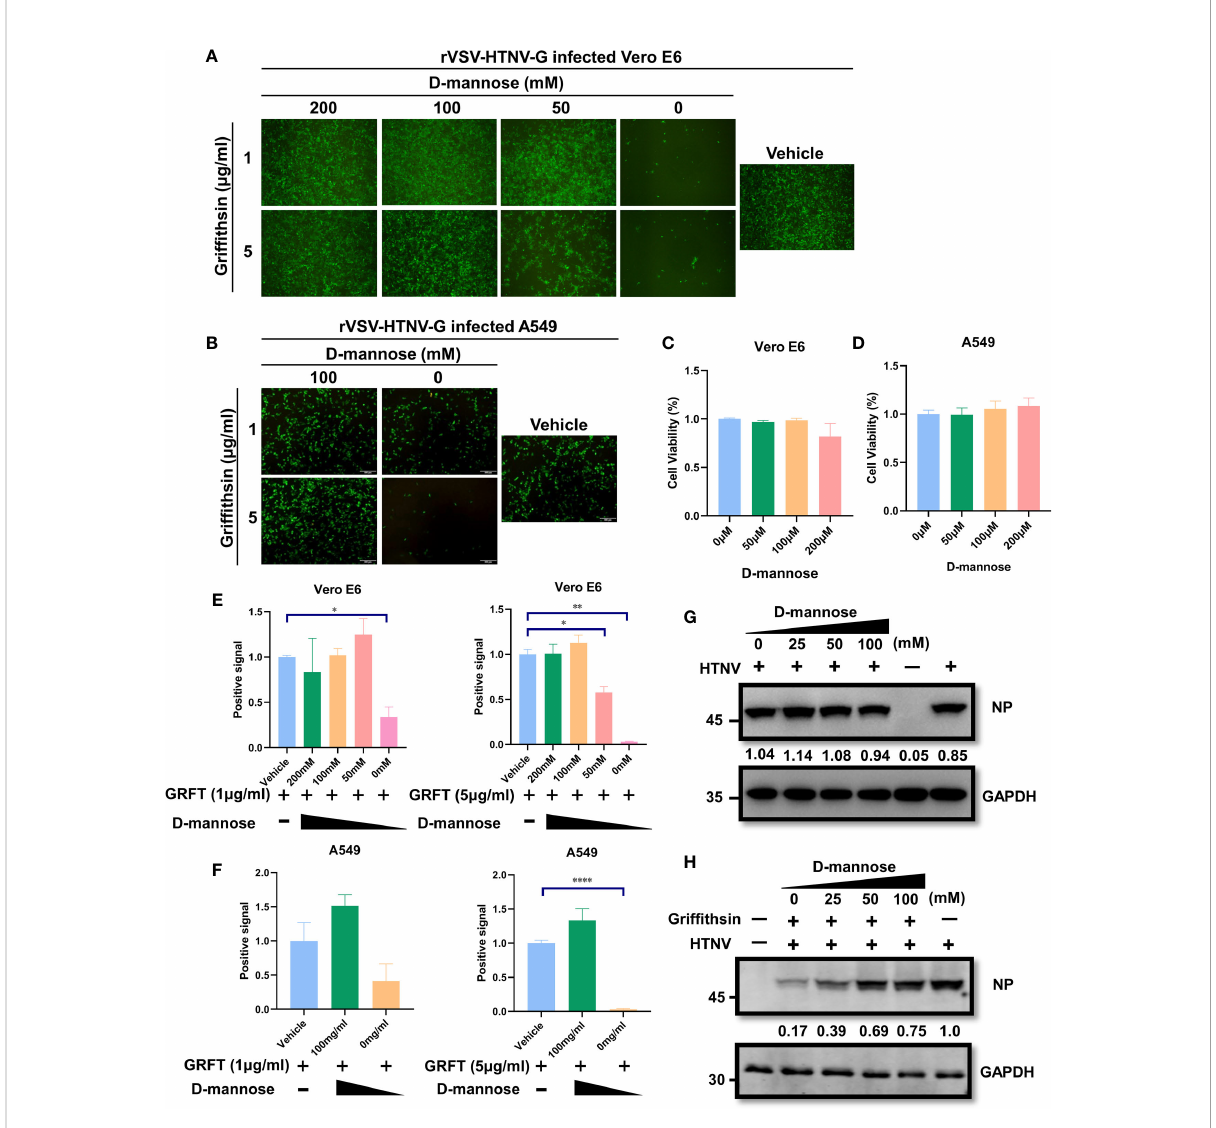
FIGURE 5 The antiviral effect of GRFT against HTNV depends on the carbohydrate-binding sites on the viral glycoprotein. (A) 5 or 1 m g/ml of GRFT was pre-incubated with 0, 50, 100, or 200 mM of D -mannose for 1 h and then incubated rVSV-HTNV-GFP for an additional 1 h. The triple mixture was used to infect Vero E6 cells (MOI = 5) and viewed at 12 hpi. Vehicle refers to the treatment group infected with a virus only, without GRFT and D -mannose. (B) A549 cells were treated similarly to Vero E6 cells but using only 100 mM of D -mannose. (C, D) Cell viability was assayed using CCK8, with absorbance (A) at 450 nm. Vero E6 (C) or A549 (D) cells were treated with increasing concentrations of D -mannose, 72 h post-treatment. (E, F) The dose-dependent D -mannose treatment dampened the inhibitory effect of GRFT on Vero-E6 (E) or A549 (F) cells. Data shown in the graphs are presented as the mean ± SDs and are representative of three independent experiments, performed in triplicate. * p < 0.05, ** p < 0.01, **** p < 0.0001. (G) D -Mannose treatment did not affect HTNV infection. HTNV was pretreated at different concentrations of D - mannose for 1 h, and then the mixture was used to infect Vero E6 cells, at 72 hpi, and the NP level within the cell was detected and normalized to GAPDH level. (H) GRFT (50 m g/ml) was pretreated with different concentrations of D -mannose for 1 h and then mixed with HTNV. The triple mixture was used to infect Vero E6 cells, and the NP level was detected at 72 hpi and normalized to GAPDH level. GRFT, grif fi thsin; HTNV, Hantaan virus; rVSV, recombinant vesicular stomatitis virus; MOI, multiplicity of infection; CCK8, Cell Counting